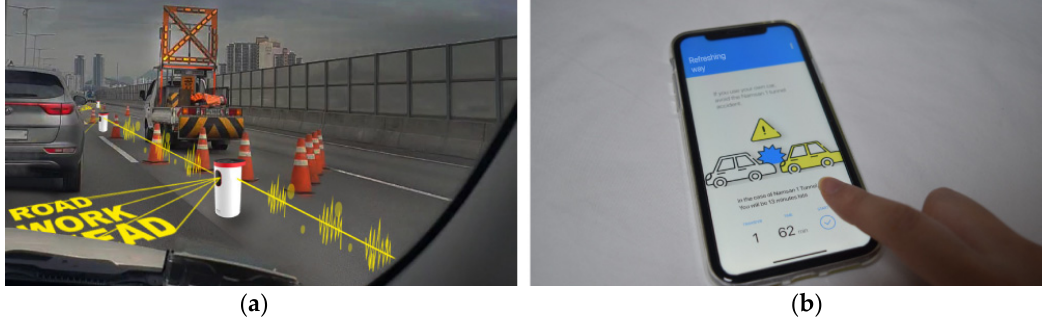
Figure 1. Scope of our research on the sensor robot and the mobile app: ( a ) first draft version of a safety sensor function module for robot communication, adapted from [3]; ( b ) our mobile app that provides information on route conditions, adapted from [6].